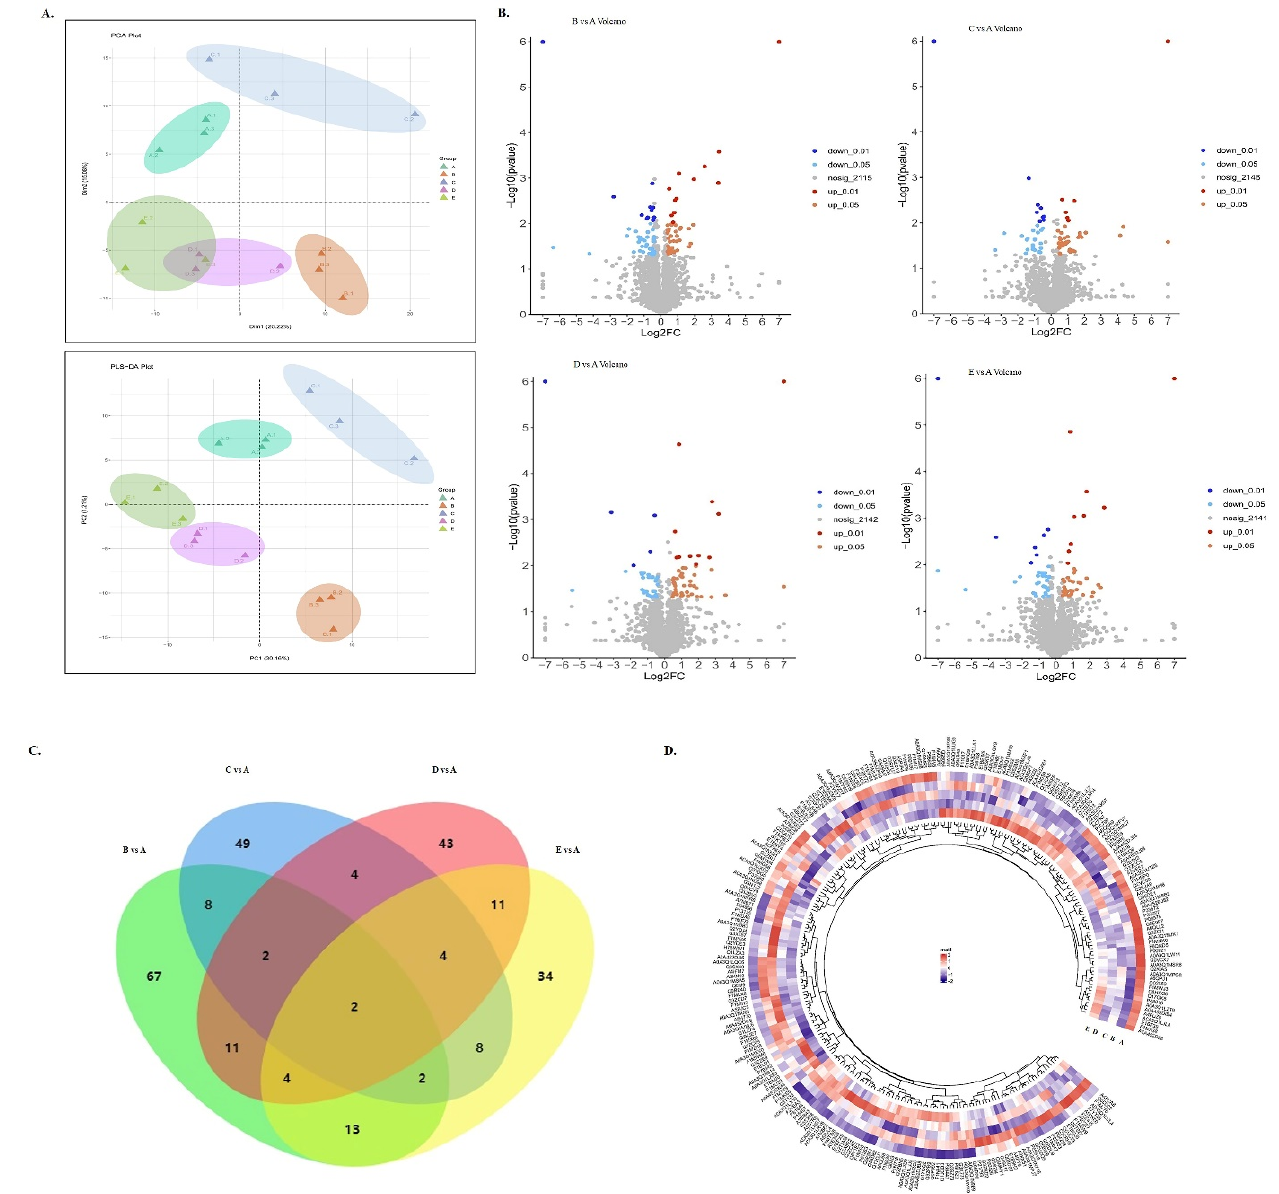
Figure 2. ( A ) PCA score plots and PLS-DA score plots between frozen treatments and CON. ( B ) Volcano plots showing differential abundance proteins (DAPs) in the beef muscle of − 12 °C/CON, − 18 °C/CON, − 38 °C/CON, and − 80 °C/CON comparisons. ( C ) Venn diagrams representing the overlap of DAPs from the − 12 °C/CON, − 18 °C/CON, − 38 °C/CON, and − 80 °C/CON comparisons. ( D ) Hierarchical cluster analysis of differential abundance proteins (DAPs) in the beef muscle of differ- ent treatments compared with CON. (In PCA score plots, PLS-DA score plots, and Venn diagrams, A represents CON; B represents − 12 °C; C represents − 18 °C; D represents − 38 °C; and E represents − 80 °C.)